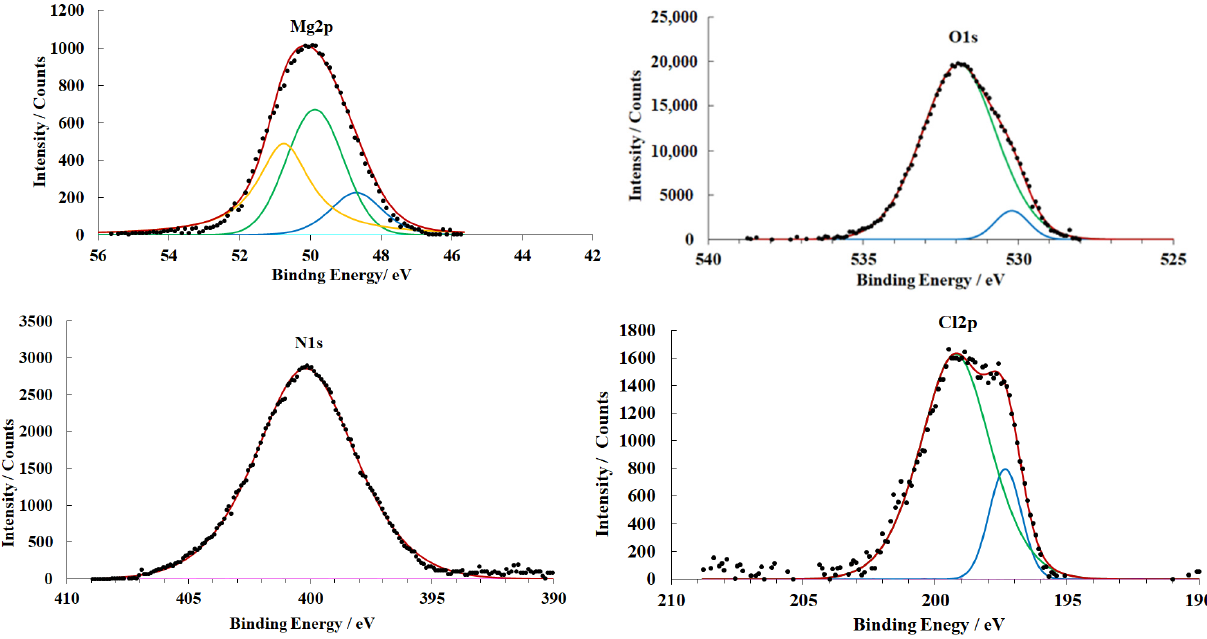
Figure 8. XPS spectra of magnesium alloy samples (preparation mode C ).